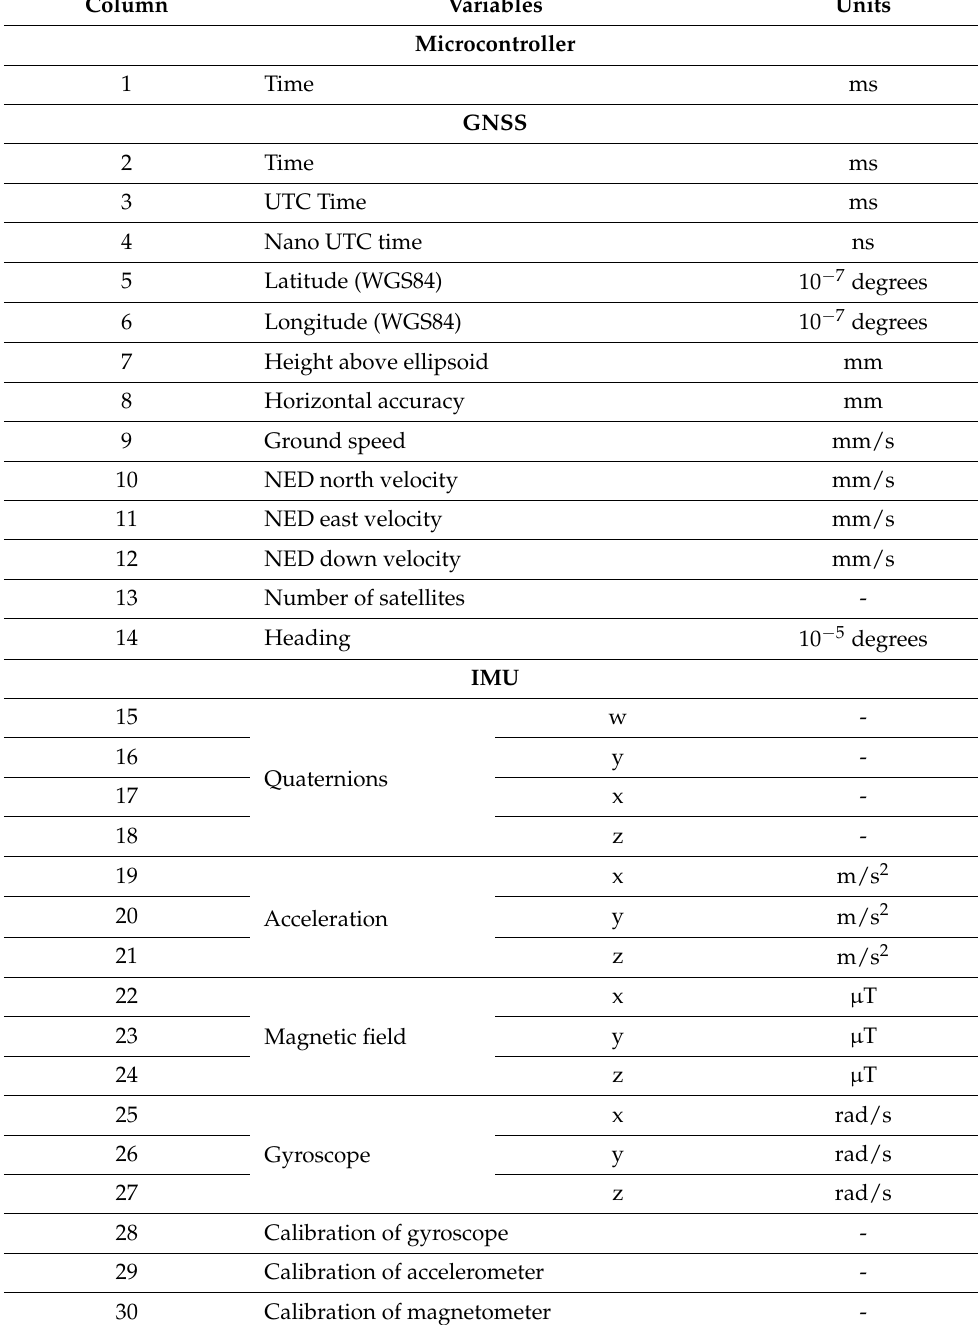
Table 2. Summary of the data recorded by the drifters and units (UTC = Coordinated Universal Time; WGS = World Geodetic System; NED = North-East-Down